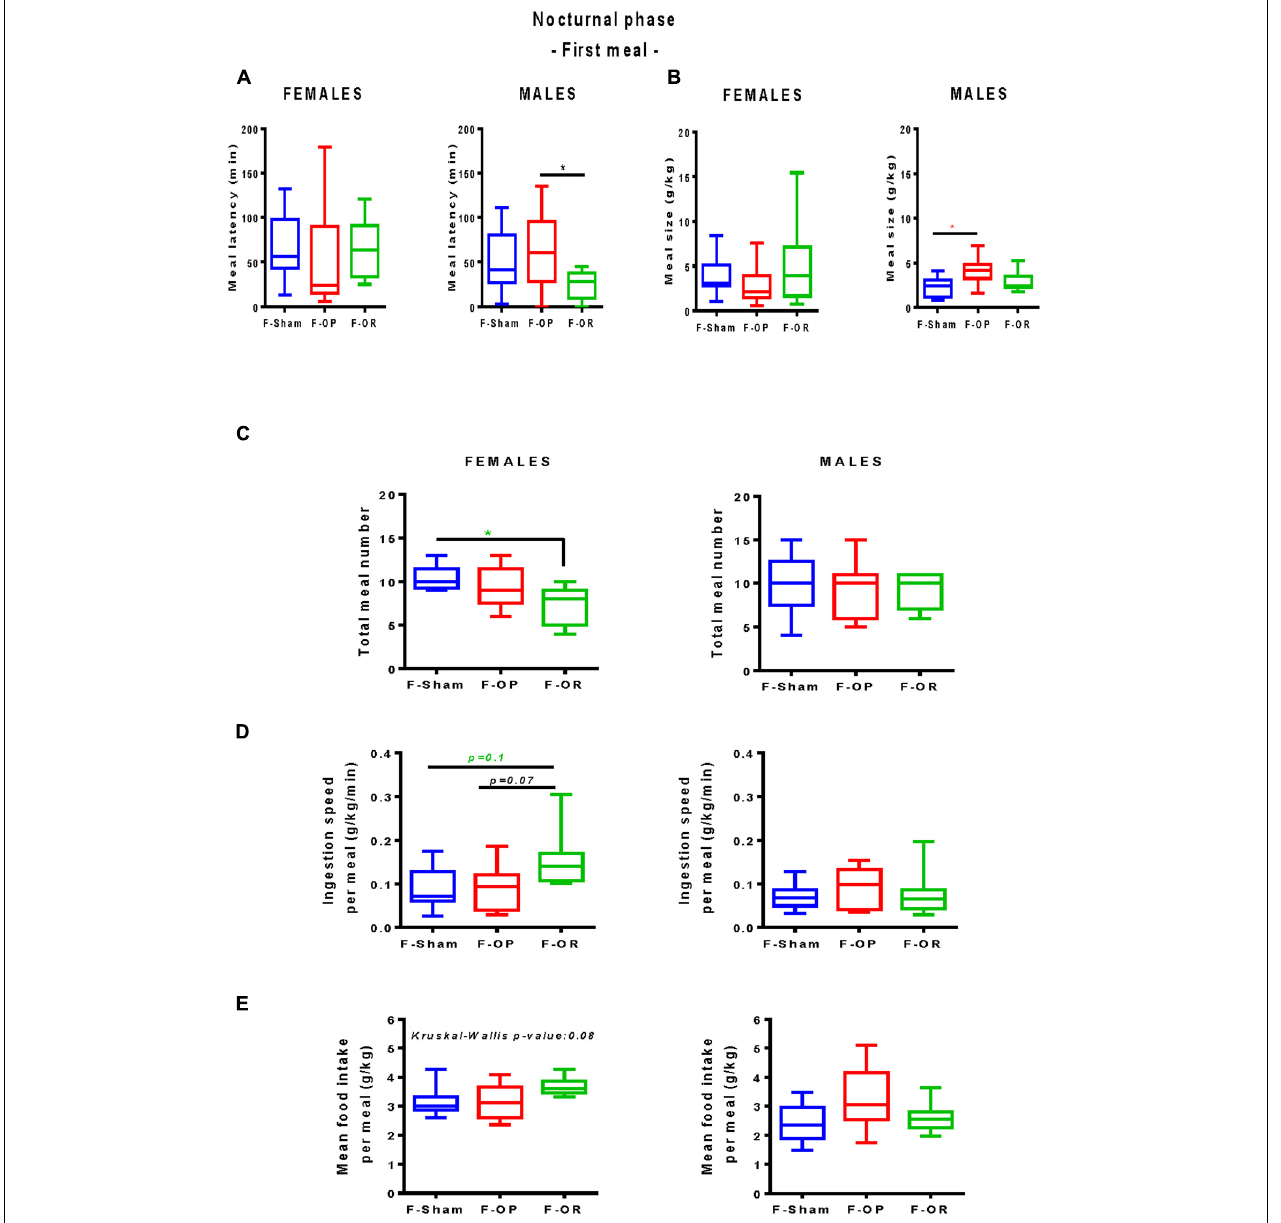
FIGURE 9 | Meal pattern. (A) Latency to eat and (B) meal size during the first nocturnal meal. (C) Total meal number. (D) Ingestion speed per meal and (E) mean food intake per meal during the nocturnal phase (12 h). Left: females ( n = 7–9), right: males ( n = 9–11). Data are medians and min–max values; * p < 0.05 indicate difference between groups, Kruskal–Wallis and post hoc Dunn’s test. Animals were 137–155-day old and fed